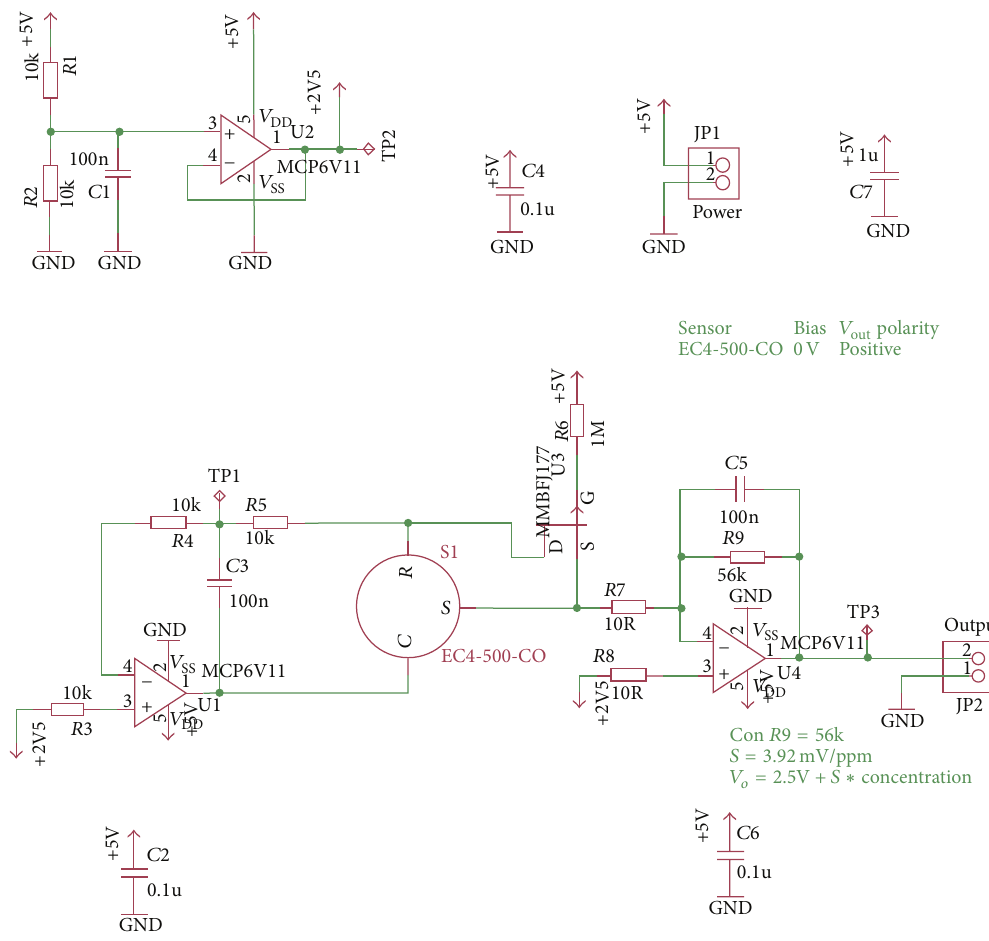
Figure 8: Circuit designed for CO conditioning signal.